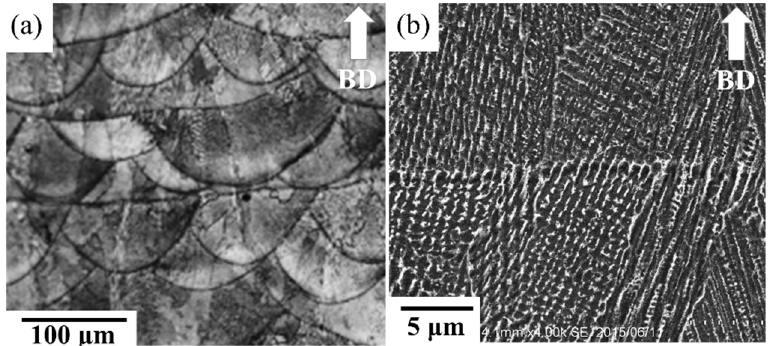
Figure 1. Secondary electron images of the as-built specimen: ( a ) lower magnification showing the molten pools structure and ( b ) higher magnification showing dendritic structures. The build direction with respect to the plane of the images is shown with an arrow.